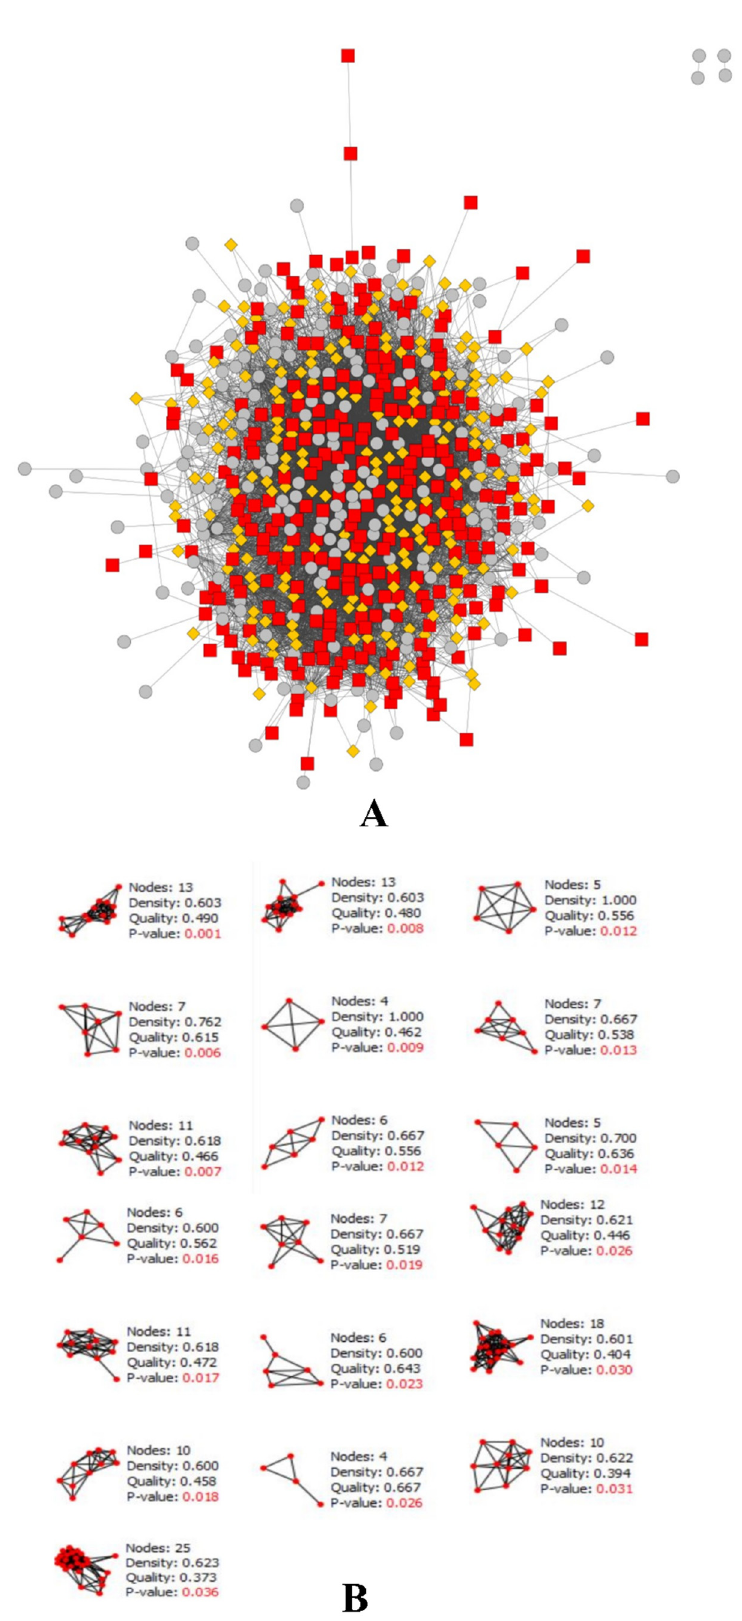
Figure 3. The ( A ) CytoCluster result, with highly significant clusters shown in red; ( B ) the significant clusters with p ‐ values of less than 0.05 obtained after analysis.